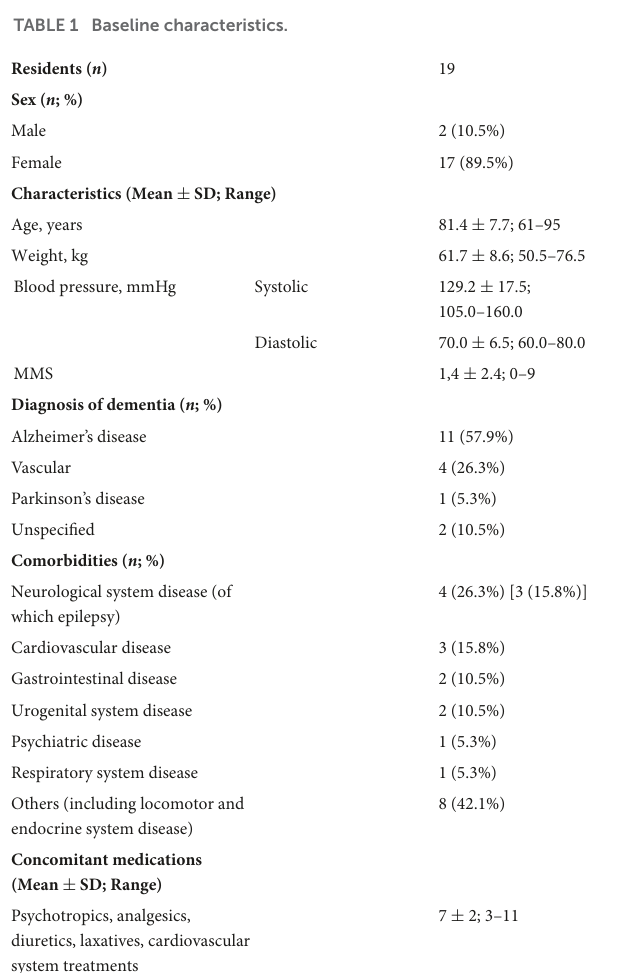
disappeared after changing to the oil formulation. For a detailed description, see Supplementary Table A1